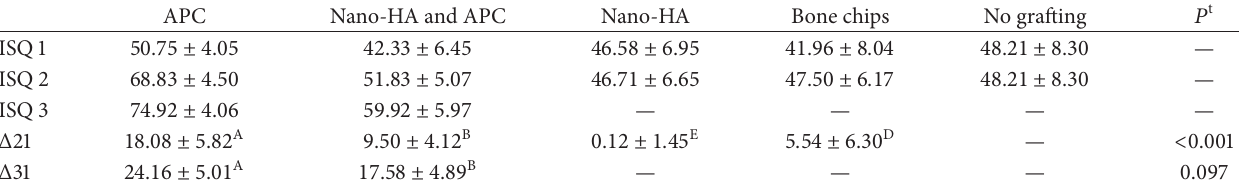
Table 1: Comparison of effect of different graft material on ISQ value of dental implants.